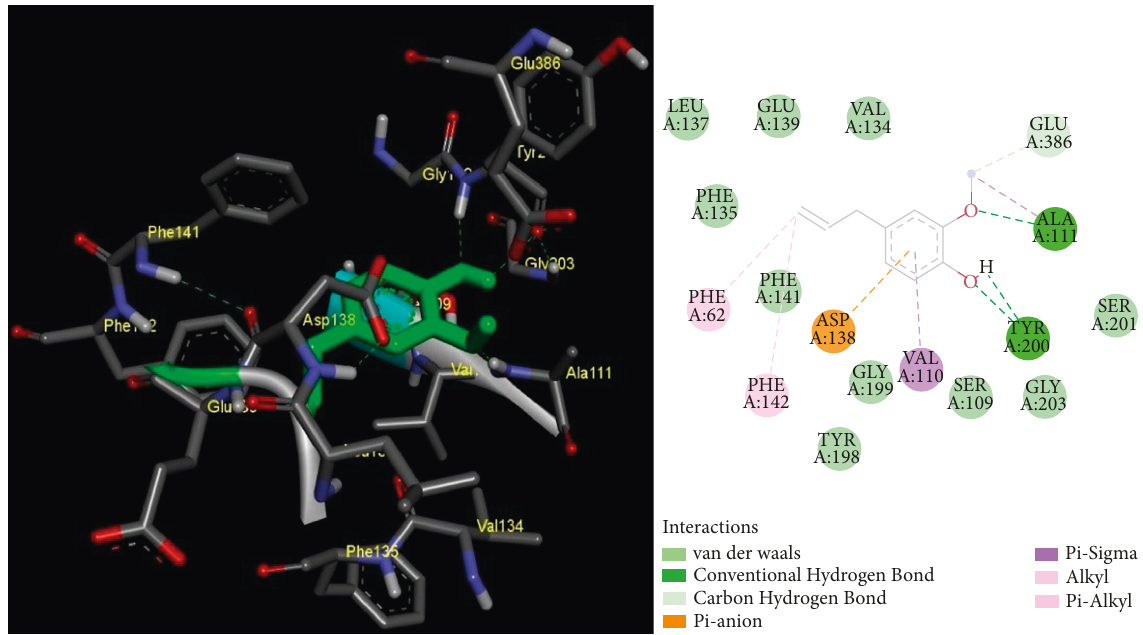
Figure 8: 2D and 3D interactions of eugenol of binding score − 8.296Kcal/mol against lipase of Malassezia furfur the polyherbal extract. Table 7 conveys the distribution property details of the polyherbal extract. Table 8 gives the herbal extract. Table 9 conveys about the excretion and toxicity property of polyherbal extract. This information is discussed in Section 3.3.4, Screening of Drug Properties.